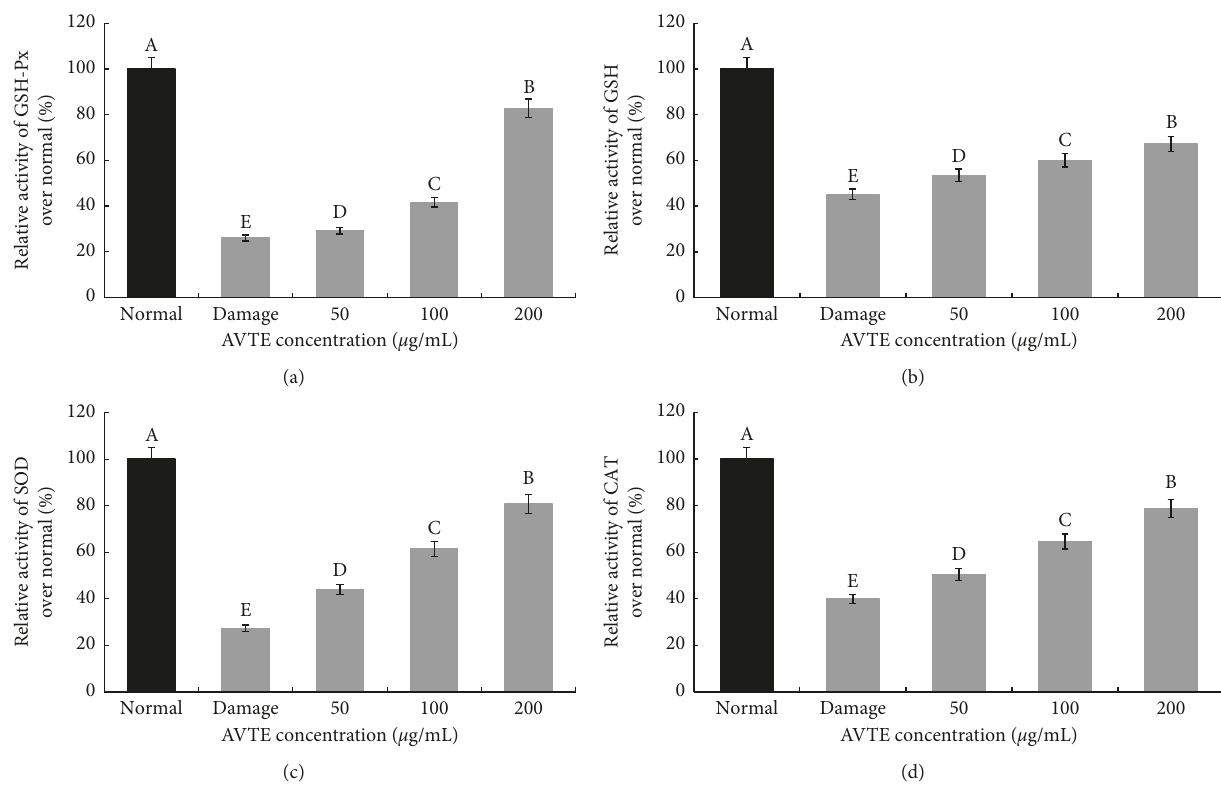
Figure 6: Effect of AVTE on the levels of SOD, GSH, GSH-Px, and CAT in 293T cells exposed to H and (d) CAT. A–E Mean values with different letters in the same bar graph are significantly different ( P < 0 . 05) according to Duncan’s multiple range